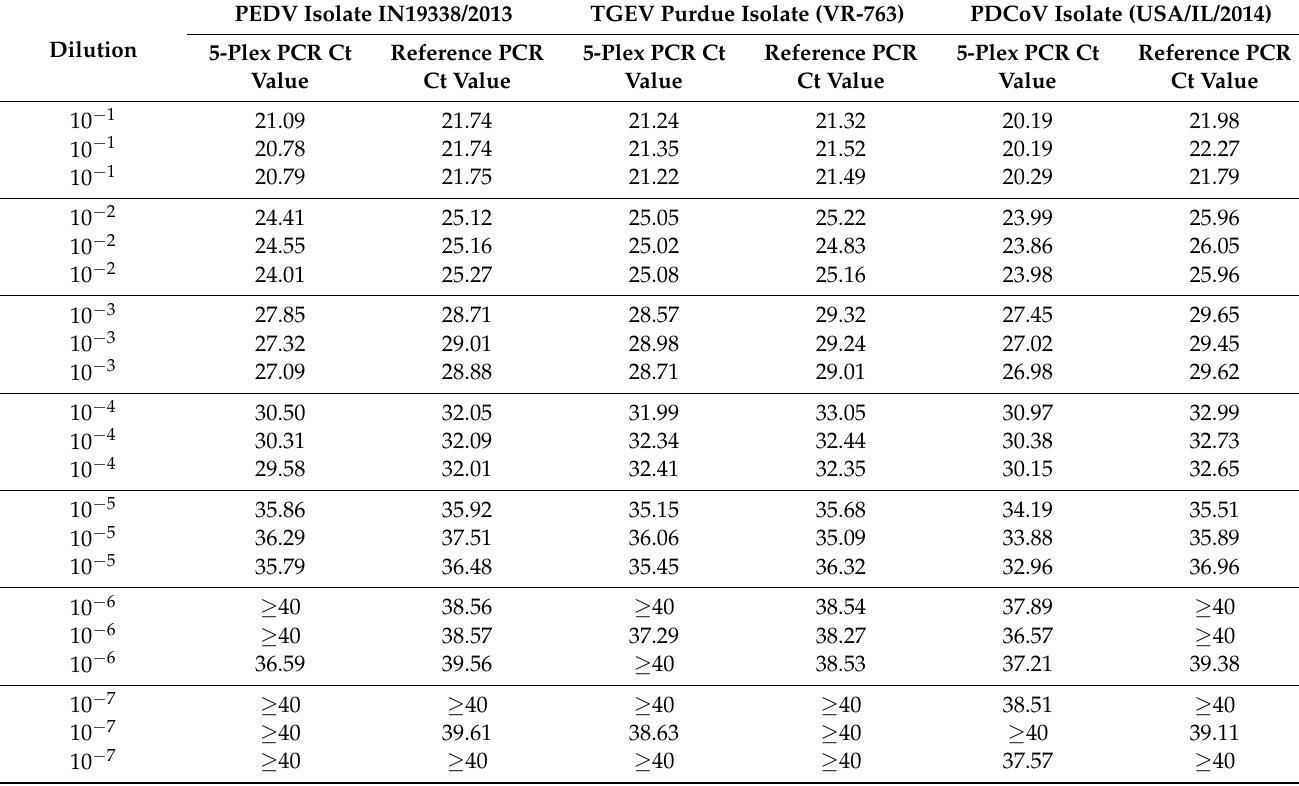
Table 5. Analytical sensitivity of PEDV/PDCoV/TGEV/SADS-CoV/XIPC 5-plex PCR and